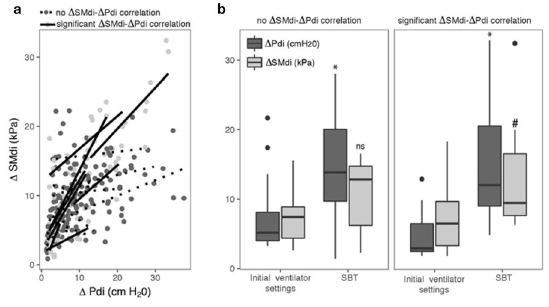
Fig. 1 a Relationship between changes and diaphragmatic shear modu‑ lus. b ΔPdi and ΔSMdi under initial ventilator settings and at the end of the